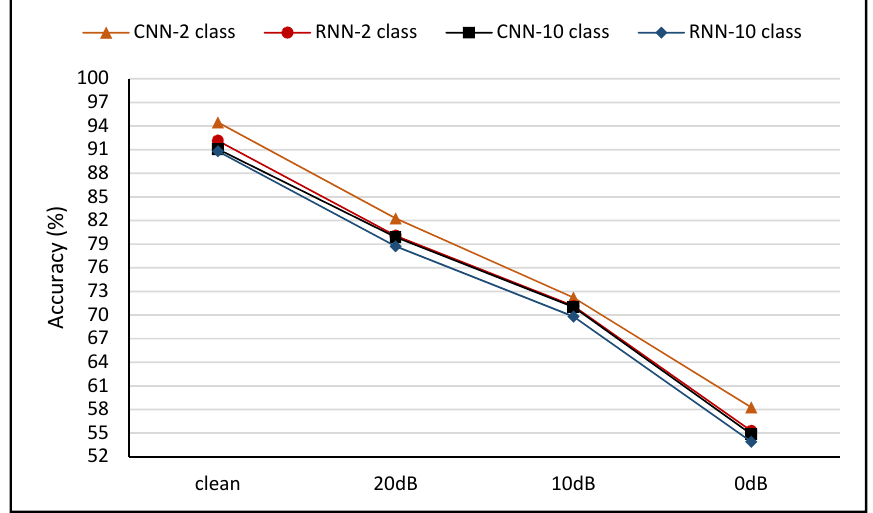
Figure 3. Impact of noisy data with non-augmented dataset.